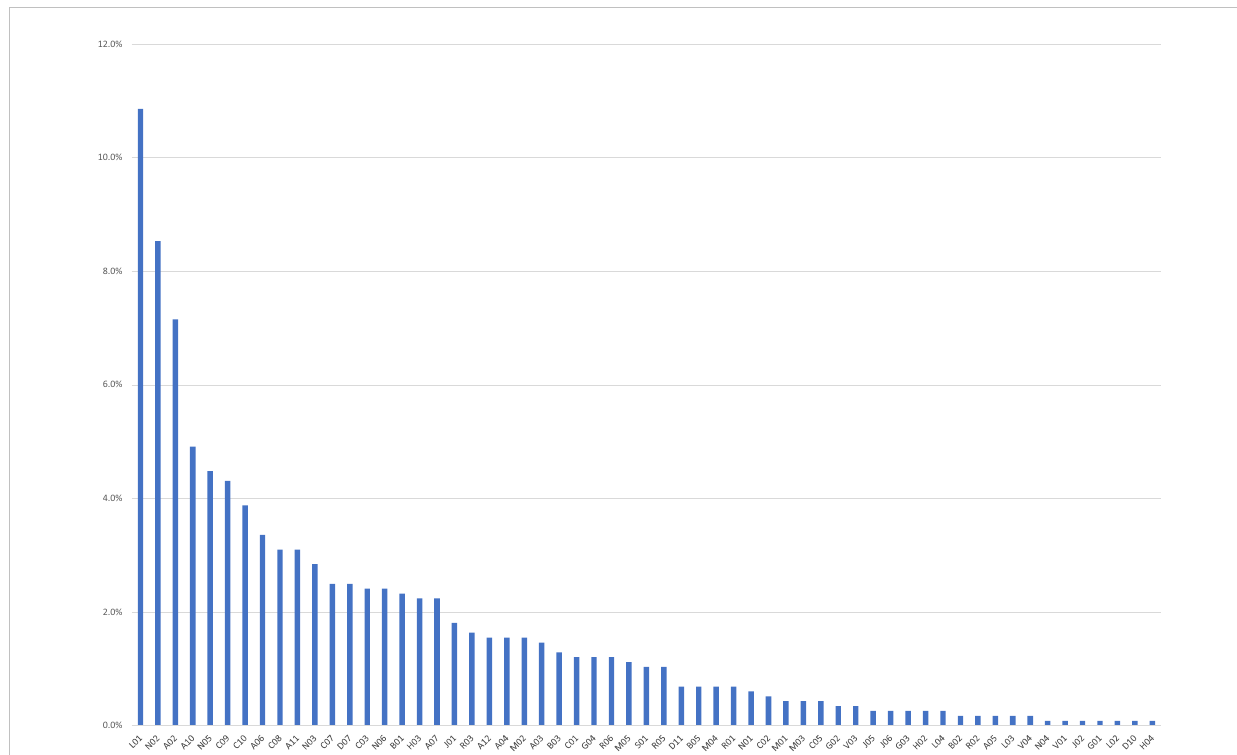
FIGURE 2 Drugs reported as concomitants in the Individual Case Safety Reports (ICSRs) collected in Eudravigilance, categorized by therapeutic reference class (Level II ATC). A02, Antacids; A03, Combinations of psycholeptics and antispasmodics; A04, Antiemetics and antinausea; A05, Biliary and hepatic therapy; A06, Drugs for constipation; A07, Antidiarrheals, anti-in fl ammatory/anti-infective agents; A10, Drugs used in diabetes; A11, Vitamins; A12, Mineral supplements; B01, Antithrombotic agents; B02, Antihemorrhagics; B03, Antianemic preparations; B05, Blood substitutes and perfusion solutions; C01, Cardiac therapy; C02, Antihypertensives; C03, Diuretics; C05, Vasoprotectives; C07, Beta blocking agents; C08, Calcium channel blockers; C09, Agents acting on the renin – angiotensin; C10, Lipid modifying agents; D07, Corticosteroids. dermatological preparations; D10, Anti- acne preparations; D11, Other dermatological preparations; G01, Gynecological anti-infectives and antiseptics; G02, Other gynecologicals; G03, Sex hormones and modulators of the genital system; G04, Urologicals; H02, Corticosteroids for systemic use; H03, Thyroid therapy; H04, Pancreatic hormones; J01, Antibacterials for systemic use; J02, Antimycotics for systemic use; J05, Antivirals for systemic use; J06, Immune sera and immunoglobulins; L01, Antineoplastic agents; L02, Endocrine therapy; L03, Immunostimulants; L04, Immunosuppressants; M01, Anti-in fl ammatory and antirheumatic products; M02, Topical products for joint and muscular pain; M03, Muscle relaxants; M04, Antigout preparations; M05, Drugs for treatment of bone diseases; N01, Anesthetics; N02, Analgesics; N03, Antiepileptics; N04, Anti-Parkinson drugs; N05, Psycholeptics; N06, Psychoanaleptics; R01, Nasal preparations; R02, Throat preparations; R03, Drugs for obstructive airway diseases; R05, Cough and cold preparations; R06, Antihistamines for systemic use; S01, Ophthalmologicals; V01, Allergens; V03, All other therapeutic products; V04, Diagnostic agents. Six drugs (0.5%) reported as concomitant were of fi cinal